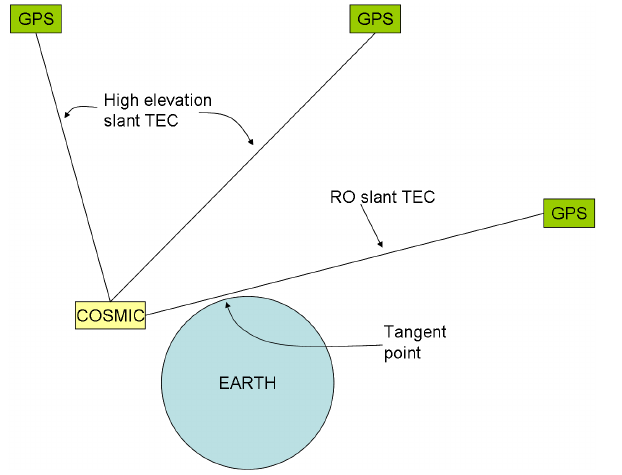
Fig. 2. Schematic diagram of COSMIC observation geometry.